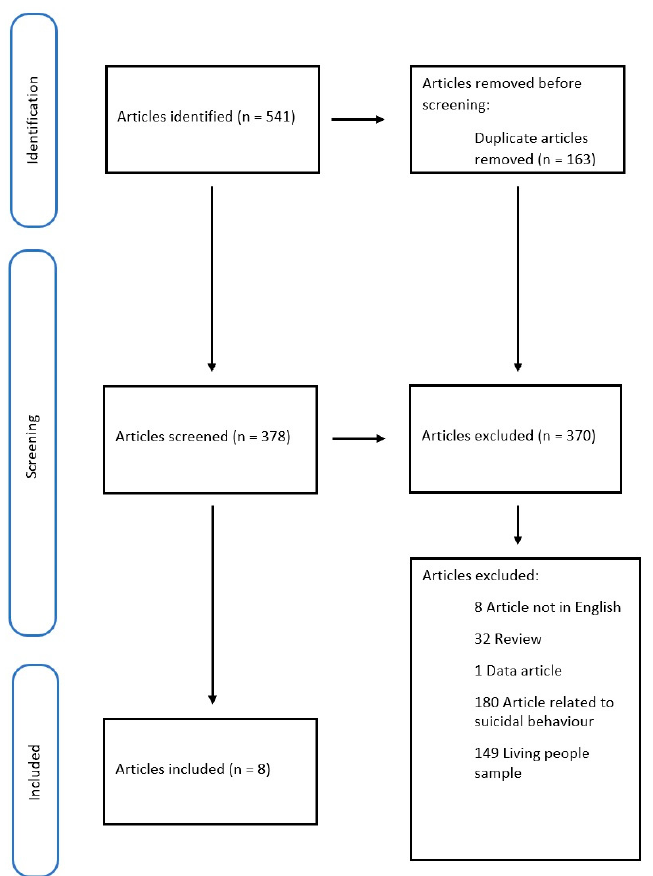
Figure 1. Search strategy following PRISMA criteria [44].